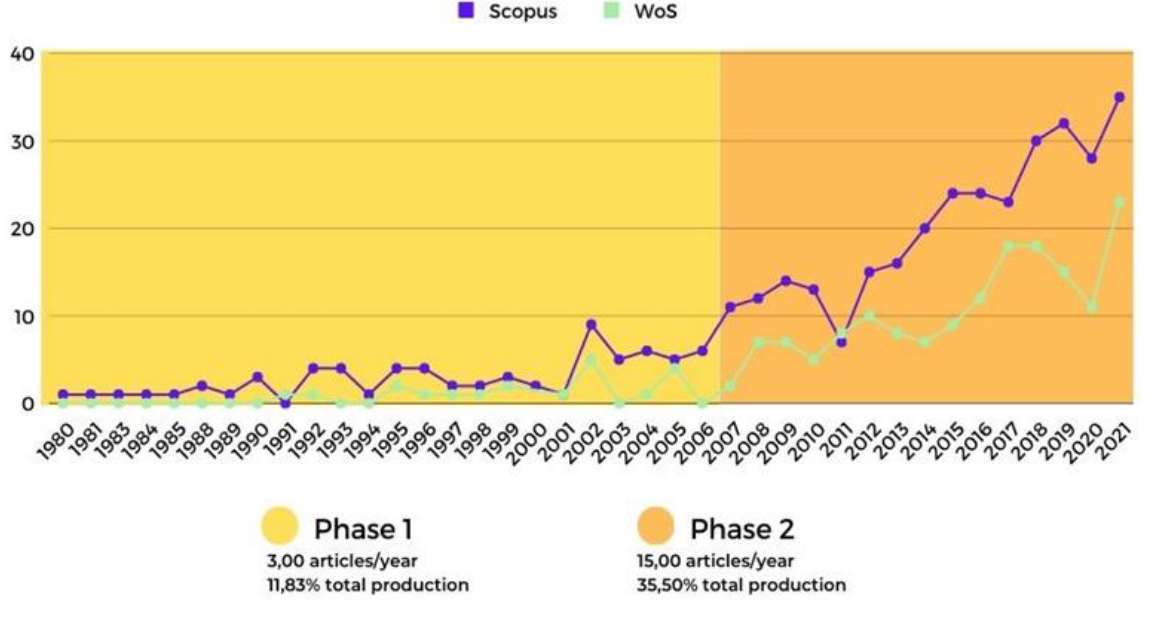
Figure 2. Trend of publications Scopus and WoS. Source: Authors’ own data .